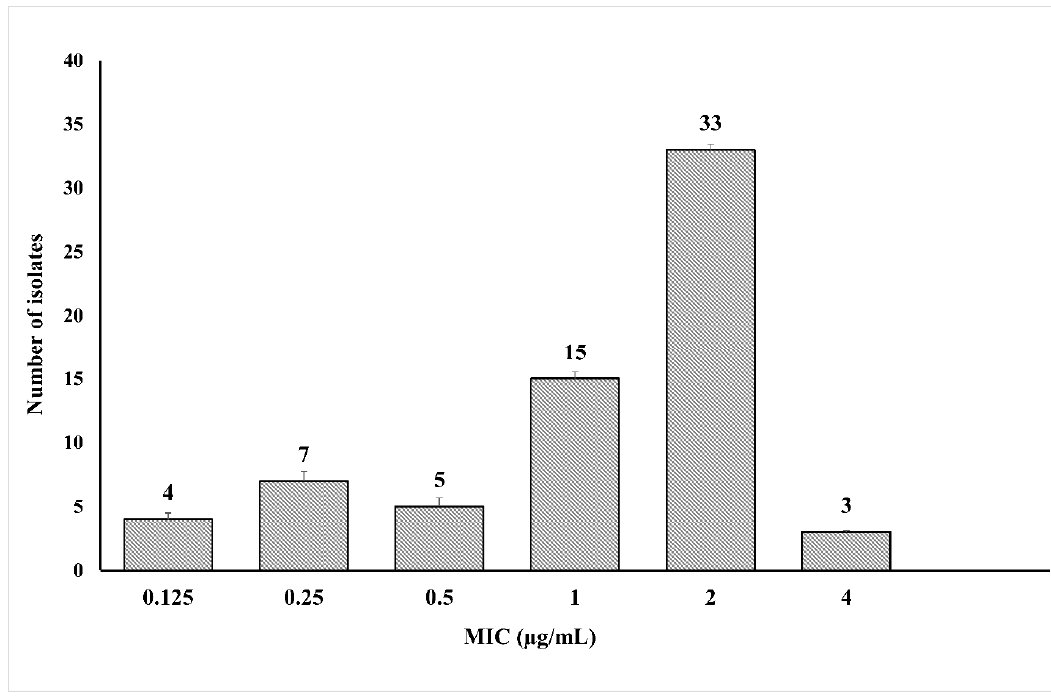
Figure 1. Distribution of colistin MIC values among 67 E. coli isolates from urinary tract infections.